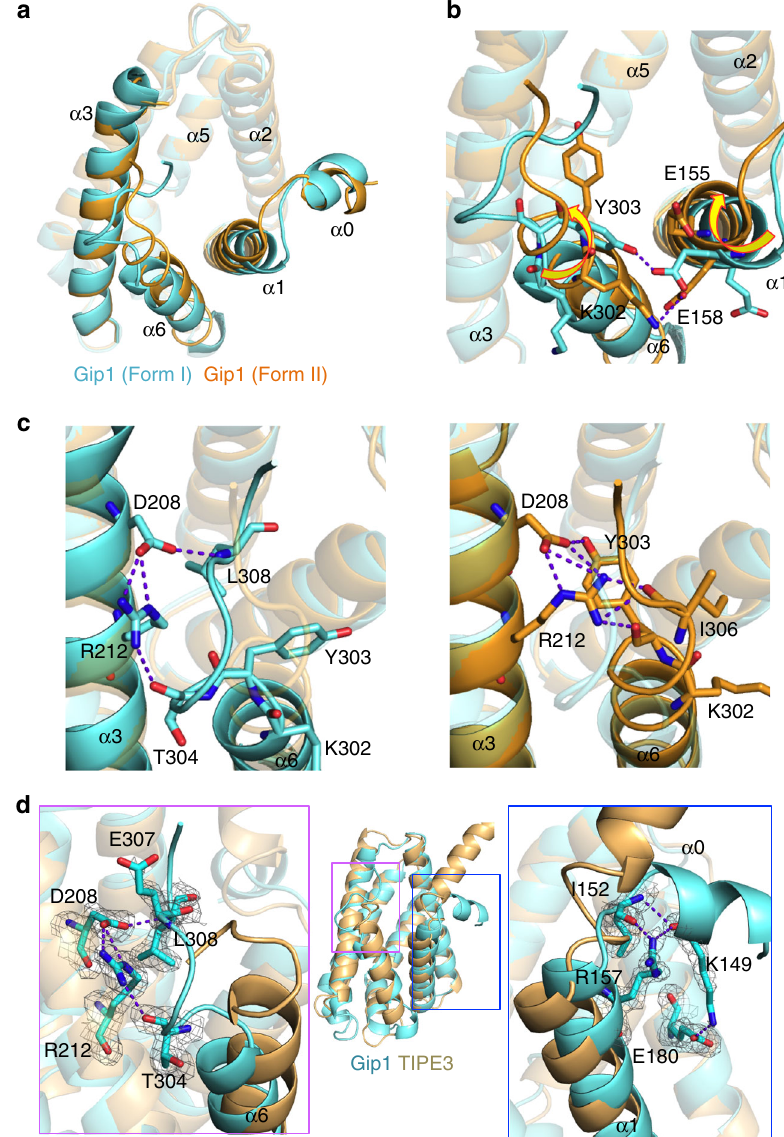
Fig. 2 Structural comparison of two forms of Gip1 and of Gip1 and human TIPE3. a Comparison of two crystal structures of Gip1(146 – 310). Two forms of Gip1 (Form I in cyan and Form II in light orange) are superimposed. b Rotational movement at α 1 and α 6. The movement reconstructs a hydrogen bond between α 1 and α 6. Hydrogen bonds are shown as dashed lines. c Reconstruction of the hydrogen bonding network at α 3 and α 6. Structural change induces the reconstruction of the hydrogen bonding network, including Asp208 and Arg212. Hydrogen bonds are shown as dashed lines. d Structural comparison of Gip1(146 – 310) in cyan and TIPE3 (PDB 4Q9V) in pale orange by superimposition. Hydrogen-bonded residues of Gip1 are shown as stick models with the 2mFo-DFc electron density map contoured at 1.0 σ . Hydrogen bonds are shown as dashed